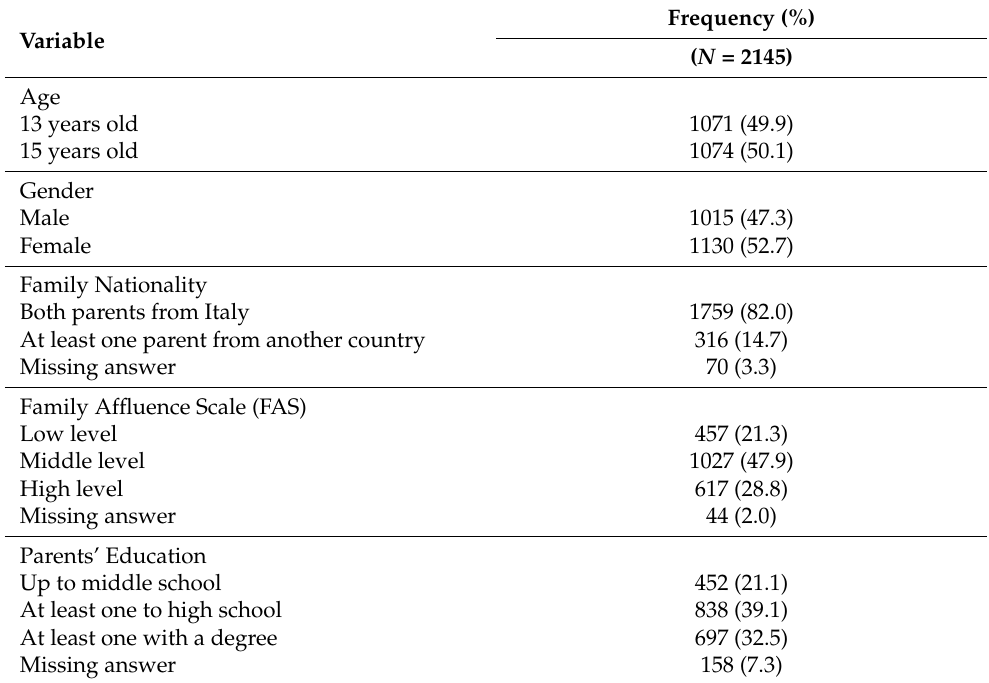
Table 1. Frequencies of socio-demographic and social stratifier